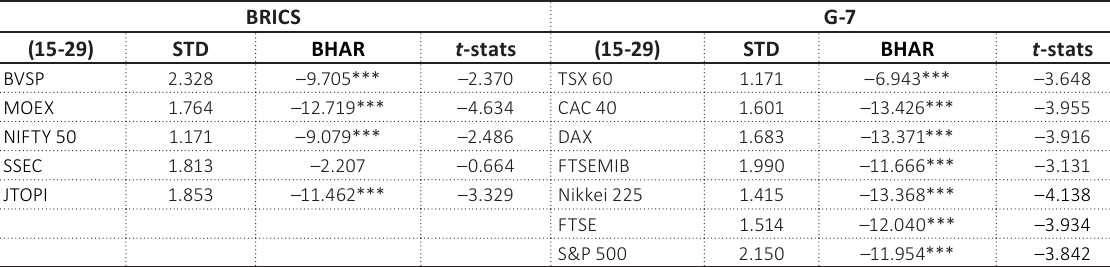
Table 4. BHAR in the event window (15-29) for G-7 and BRICS